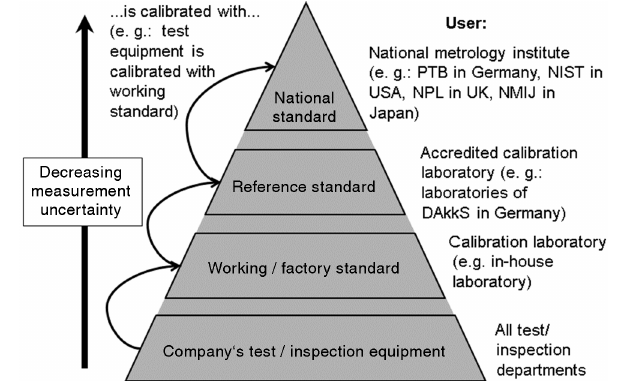
Figure 5. Data exchange between manufacturing machine and mea- suring device for the implementation of a “closed loop” in lens pro- duction.